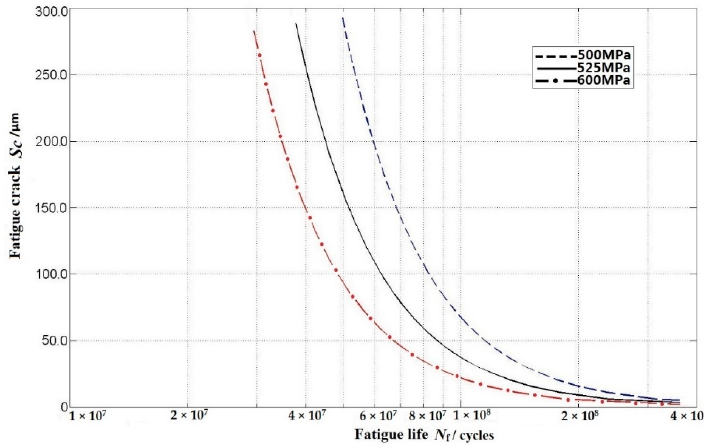
Figure 9. Fatigue life curves with 500 MPa, 525 MPa, and 600 MPa.